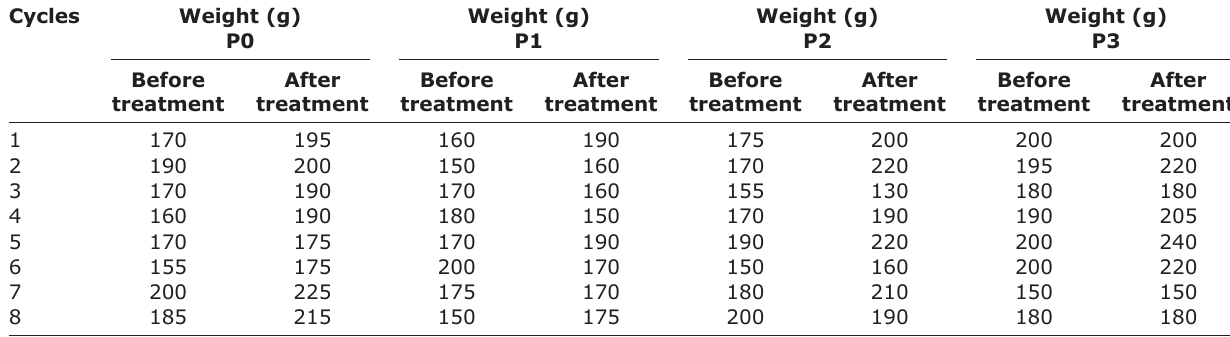
Table-1: Results of the white rats’ body weight measurement (g) before and after the treatments.